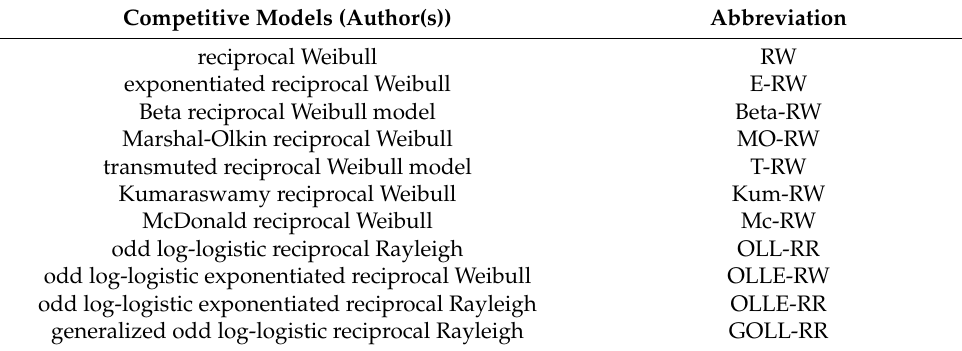
Table 1. Some competitive